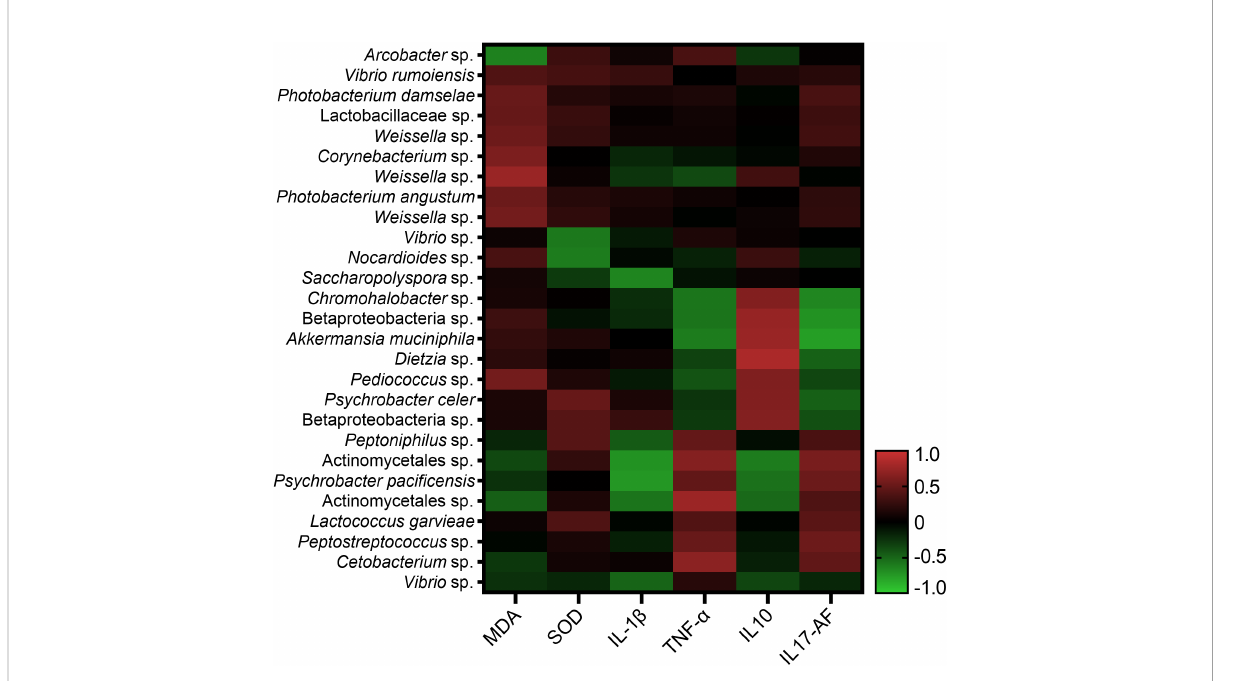
FIGURE 7 Correlation analysis of 27 ASVs of intestinal bacterial community and immune response